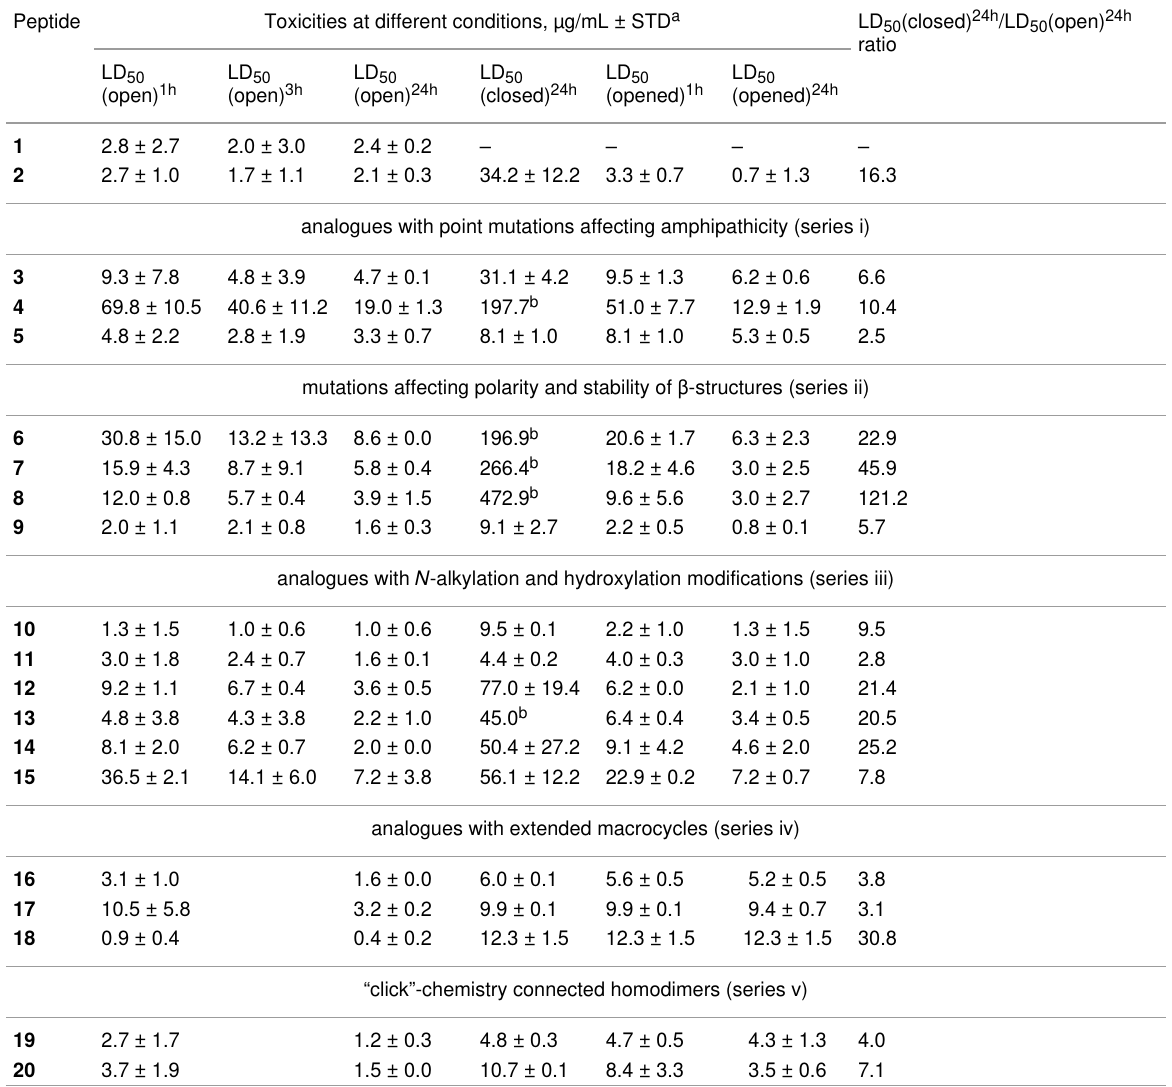
Table 2: Toxicities and LD 50 (closed) 24h /LD 50 (open) 24h ratios for the photoswitchable peptides. The peptides are grouped in series (i–v) according to their original design in [30].